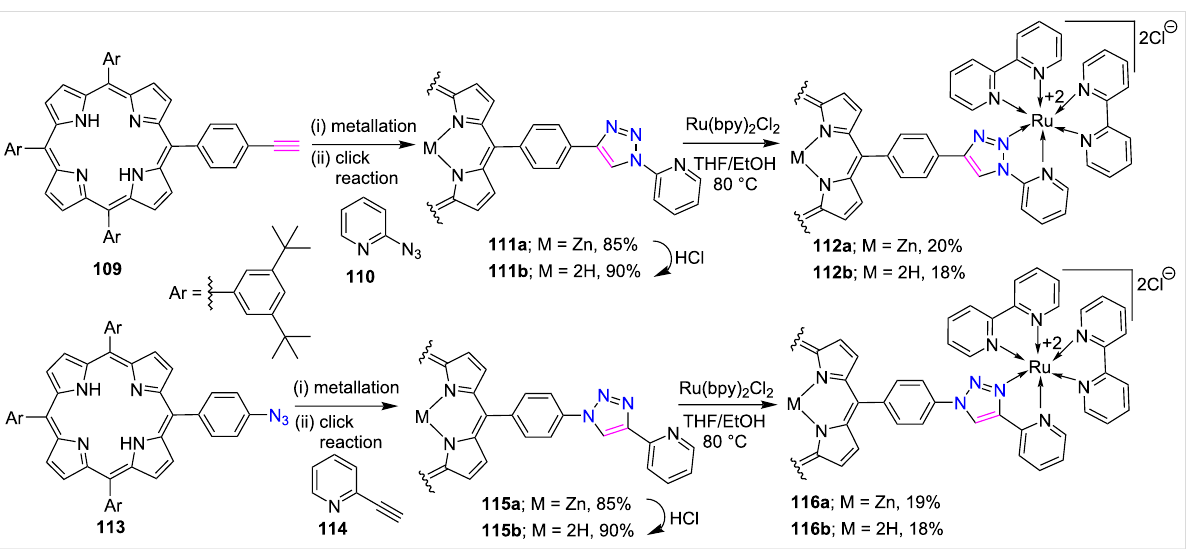
Scheme 22: Synthesis of porphyrin-ruthenium (II) conjugates 112a , b and 116a , b . Reaction conditions: (i) Zn(OAc) 2 , CHCl 3 /MeOH (ii) CuSO 4 ·5H 2 O, sodium ascorbate, DIPEA, CH 2 Cl 2 /EtOH/H 2 O, 50